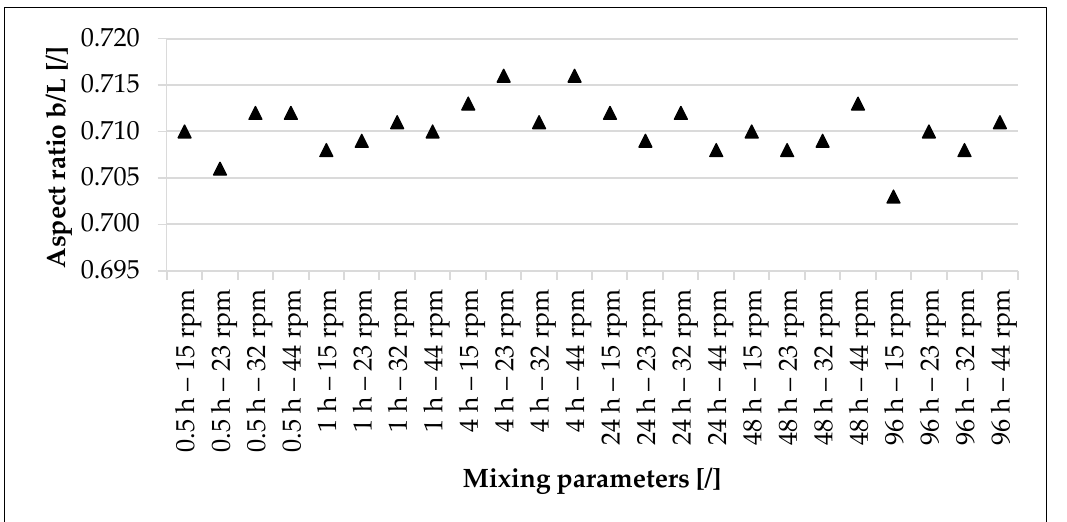
Figure 3. Influence of the mixing process on the sphericity of the sinter material. Six mixing durations are considered, each with four mixing intensities. Determined with Camsizer XT.